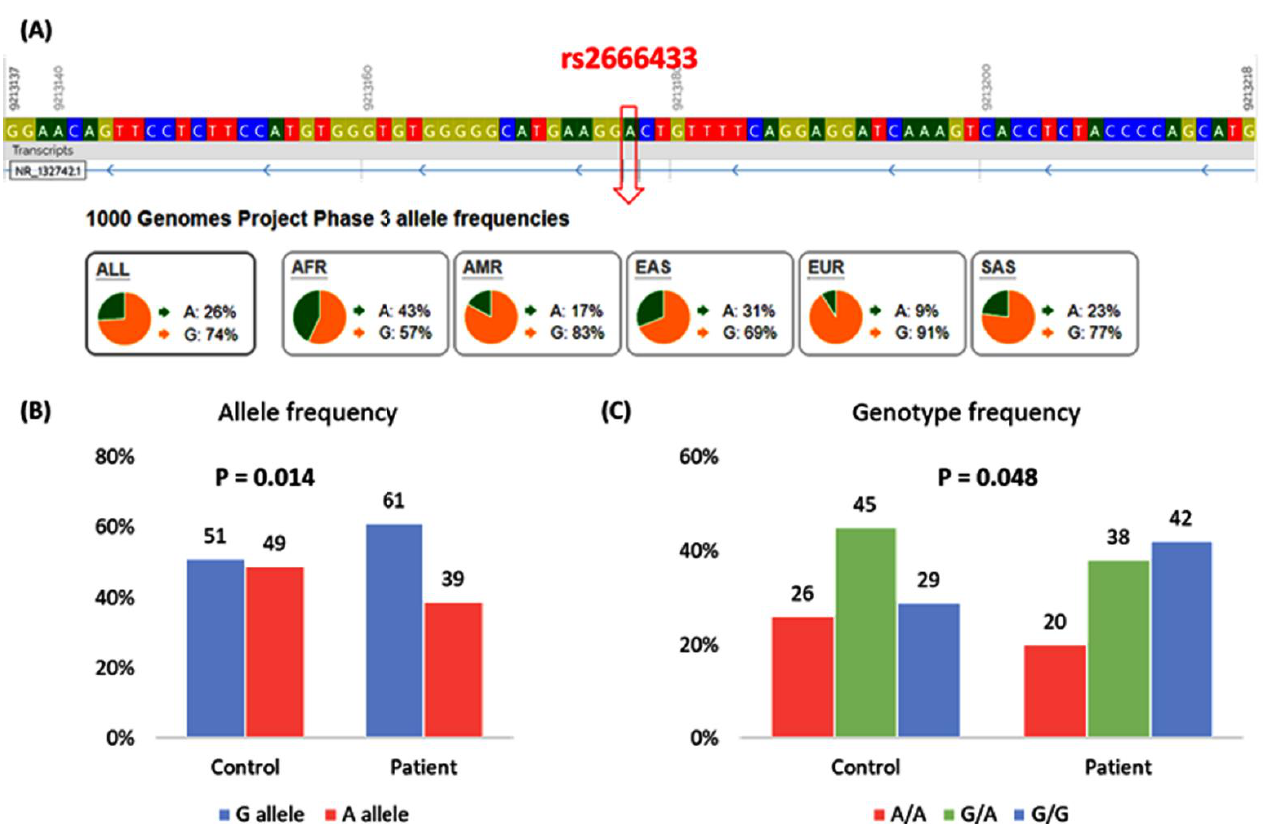
Figure 2. Genotype and allele frequencies of MIR34A rs2666433 (A/G) polymorphism. ( A ) Genomic location and allele frequencies of rs2666433 variant. Data source: (Ensembl.org) (last accessed on 25 May 2021). ( B ) Allele frequency in the current study. ( C ) Genotype frequency in the current study. Values are shown as a percentage. A Chi-square test was used. p -value < 0.05 was considered as statistically significant. The p -value for Hardy–Weinberg equilibrium is 0.21.